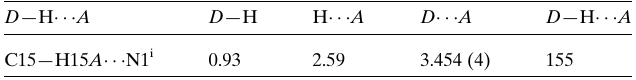
Table 1 Hydrogen-bond geometry (A˚ , (cid:2) ).